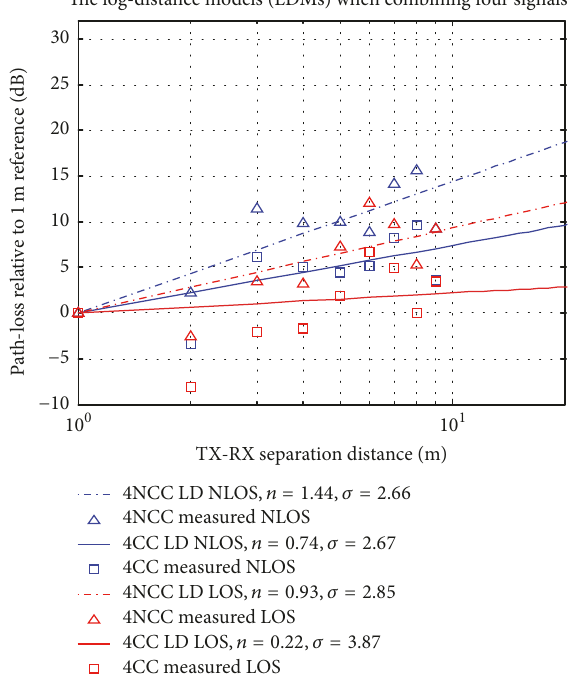
Figure 5: LDMs along with the measured scattered data when combining four signals coherently and noncoherently for the LOS and NLOS propagation